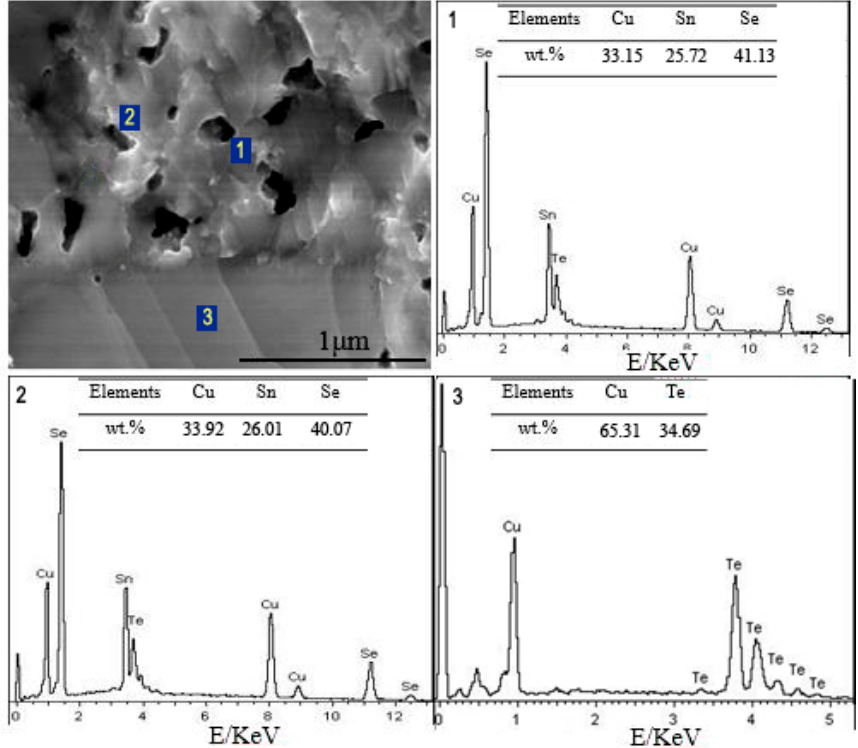
Figure 5. SEM images of the 1.2 vol.% Cu–Te / Cu 2 SnSe 3 sample and EDS (Energy Dispersive X-ray Spectroscopy) results.